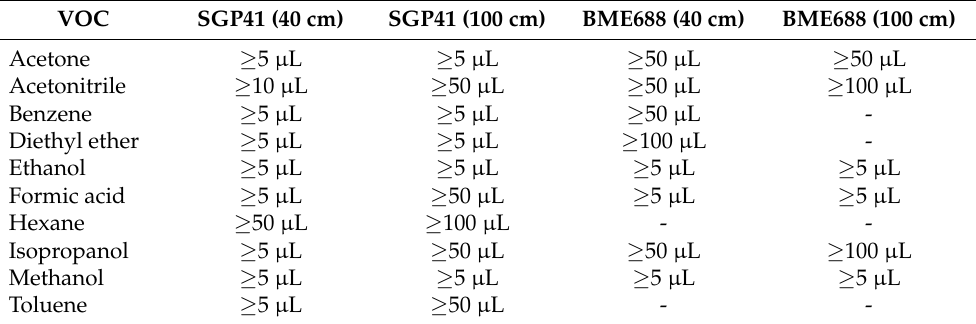
Table 1. SGP41 VOC-Index and BME688 IAQ-Index success responses to 200 index thresholds for the tested